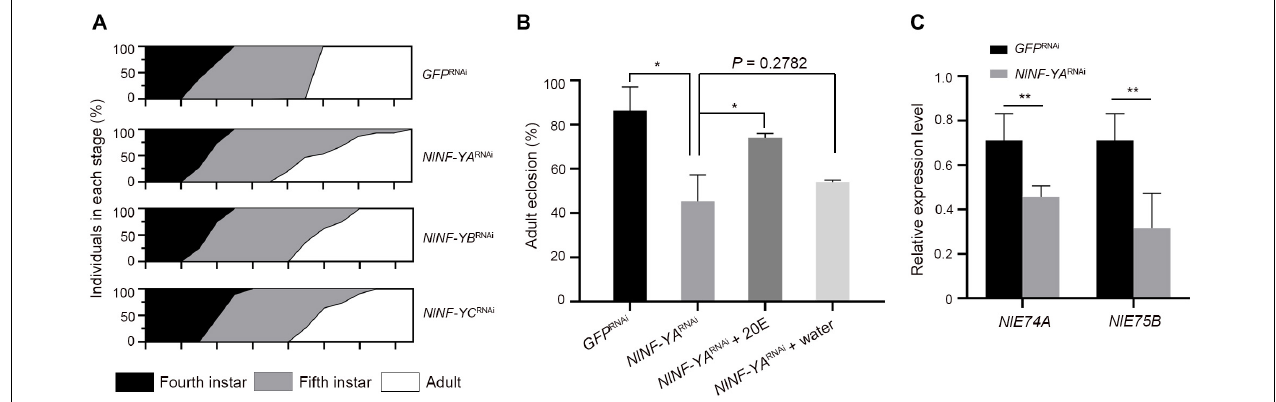
FIGURE 7 | Nymphal duration and adult eclosion of dsRNA-treated BPHs. (A) Third-instar nymphs (0–24 hAE) were microinjected with dsRNAs targeting NlNF-YA ( n = 660), NlNF-YB ( n = 435), NlNF-YC ( n = 480), or Gfp ( n = 442). The curve in different developmental stages indicates the molting ratio. ( B ) The nymph-adult eclosion rate of BPHs. Fourth-instar nymphs (36–48 hAE) were microinjected with dsRNAs targeting NlNF-YA or Gfp , and then 20E or distilled water was microinjected when nymphs proceeded the fifth-instar stage. (C) The expression of NlE74A and NlE75B in context of NlNF-YA knockdown. The relative expressions of NlE74A and NlE75B were normalized to the expression of rps11 . Statistical comparisons between two groups were performed using two-tailed Student’s t -test (* P < 0.05, and ** P < 0.01).